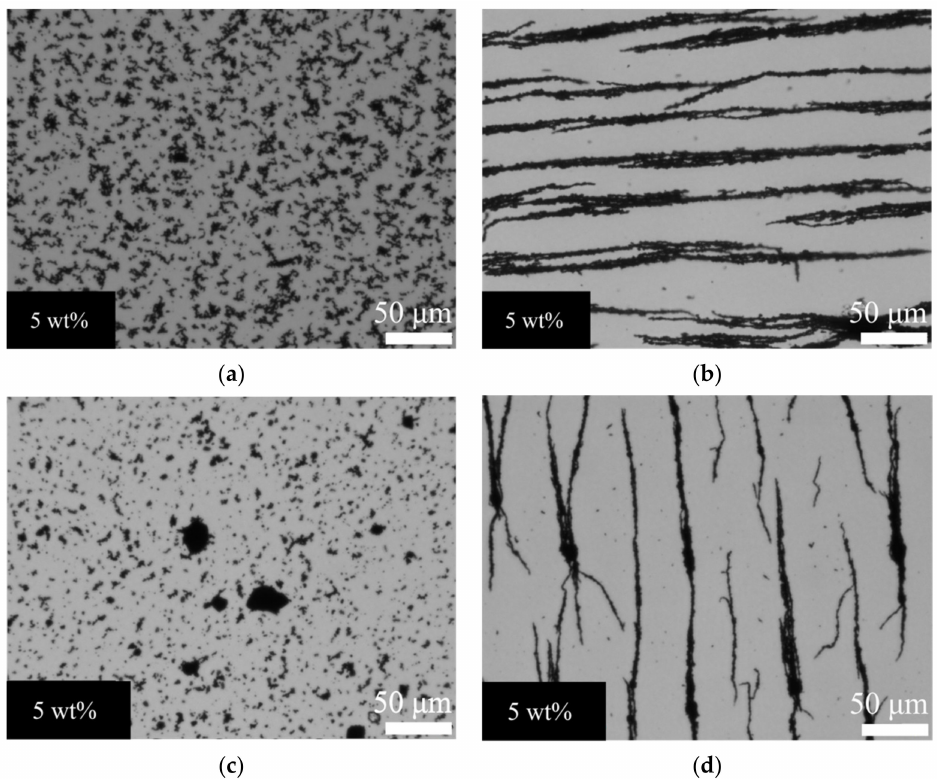
Figure1. OpticalmicrographsofthecompositefilmsconsistingofPDMSand5wt%magneticnanoparticles: ( a ) unstructured Fe 3 O 4 -PDMS sample, ( b ) structured Fe 3 O 4 -PDMS sample, ( c ) unstructured